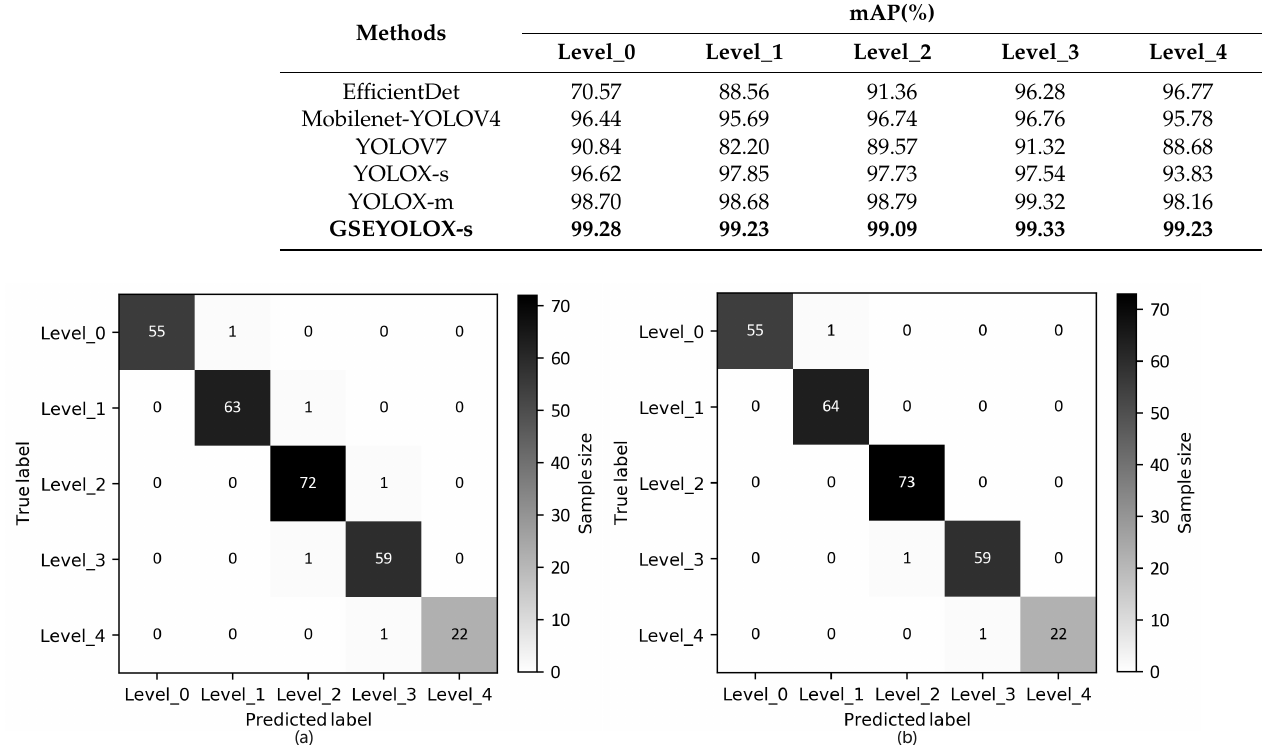
Table 5. The mAP of FHB severity grading detection using six target detection models.